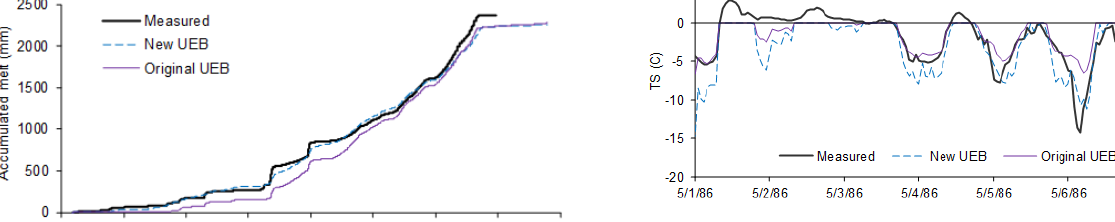
Figure 12. Comparisons of surface temperature of snow in 1986 at